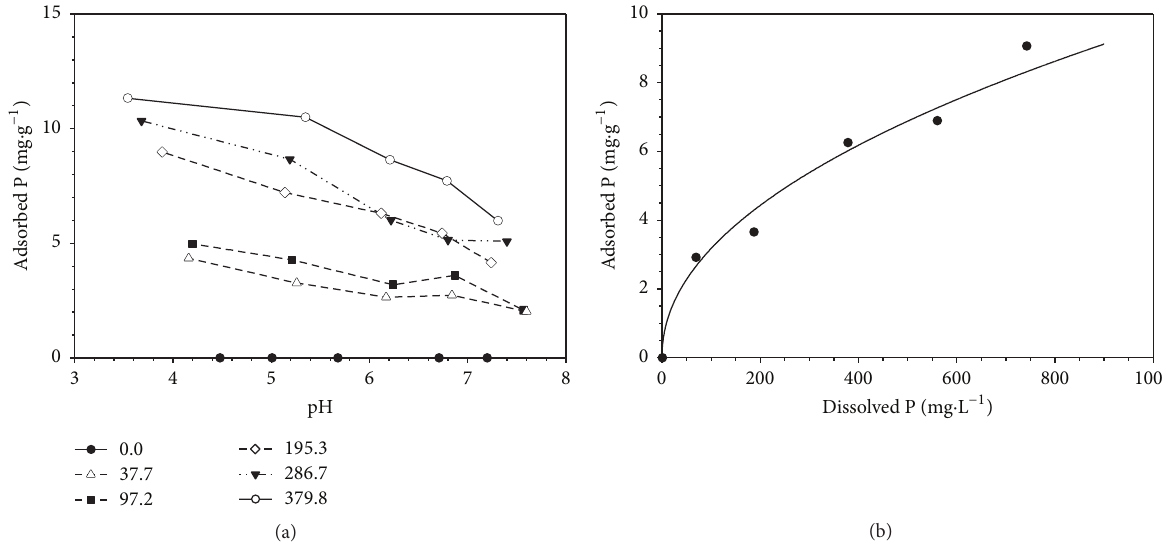
Figure 1: (a) Phosphate adsorption envelope at five pH levels of the soil material for various concentrations of added phosphate-P (10mM KCl background solution, 24 ∘ C). Legend indicates the milligrams of phosphate-P added per gram of soil material. Lines connecting data points were included to aid in visualizing trends in the data. (b) Phosphate adsorption isotherm of soil at pH 6.0 with a van Bemmelen-Freundlich model